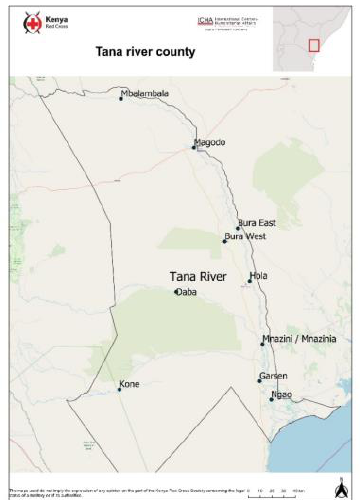
Figure 1. Study area